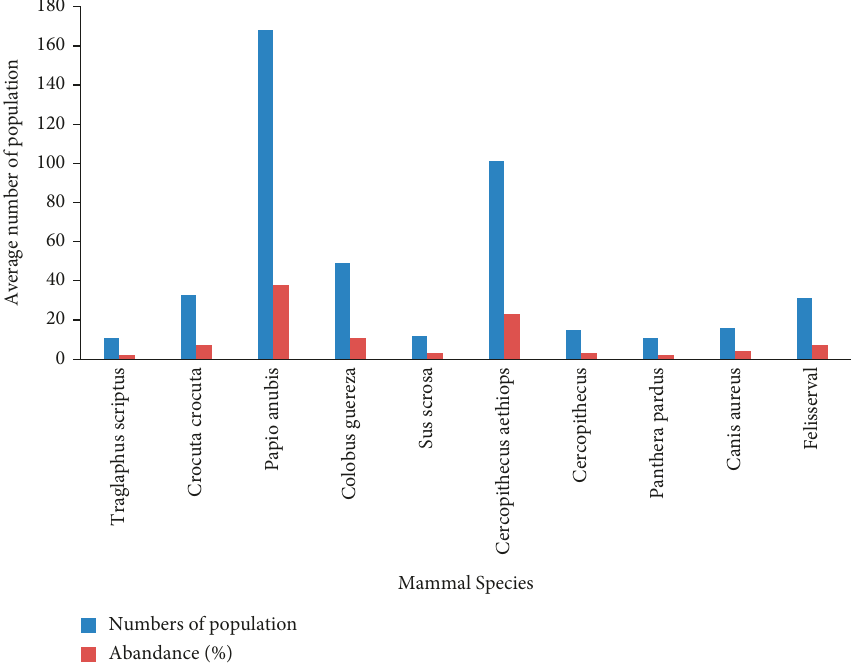
Figure 5: Number of population and relative abundance